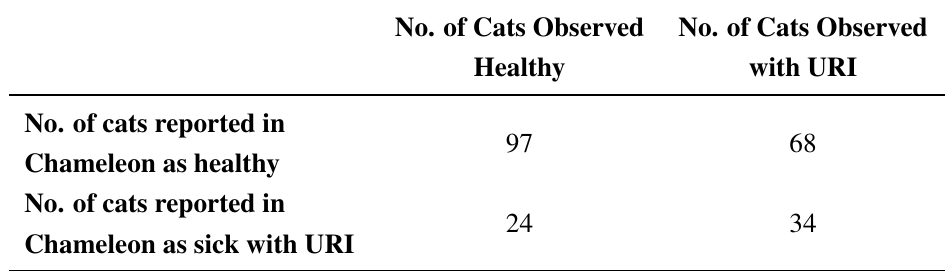
Table 3. Upper respiratory infection (URI) diagnosis in Chameleon vs. observed URI